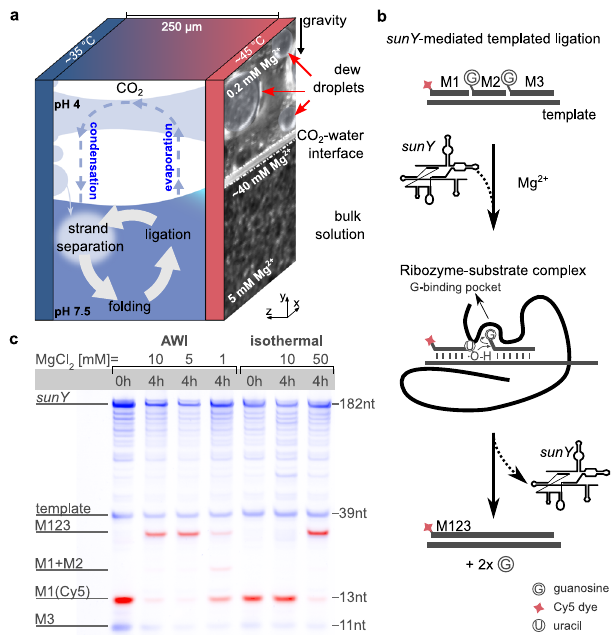
Fig.1|HeatedAWI-systemscreatemicrowatercyclesthatenableRNAfolding, ligation, and strand separation at low magnesium